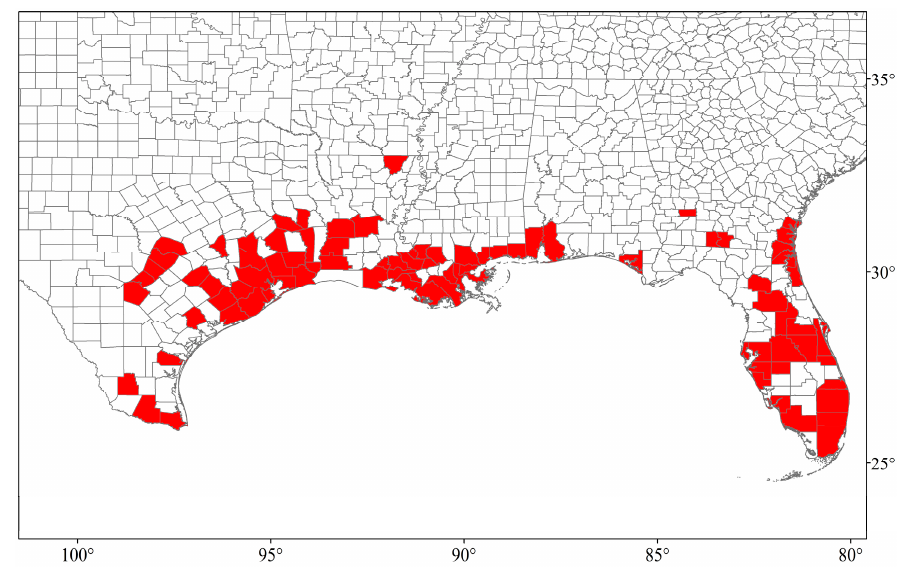
Figure 2. Current known distribution of N. fulva in counties of Texas, Louisiana, Mississippi, Alabama, Florida, and Georgia as of September, 2016 [13,14,22].